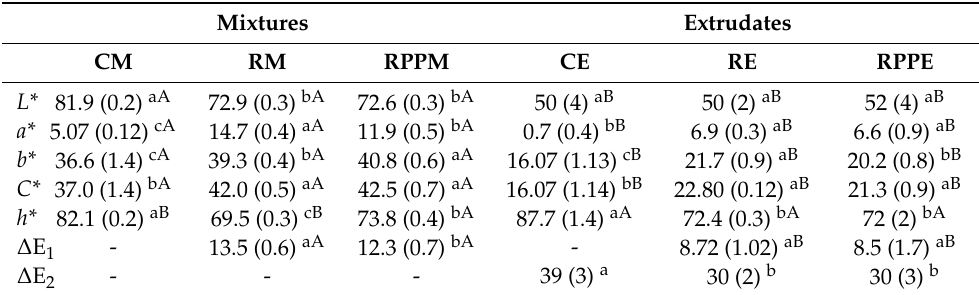
Table 3. Mean values (and standard deviations) of color coordinates ( L* , a* , b* , C* , and h* ) and total color differences ( Δ E) of the corn mixtures and extrudates.